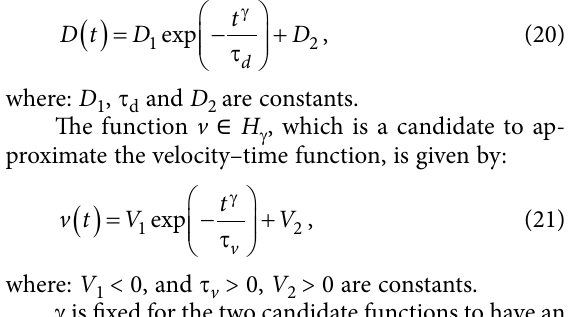
Fig. 8. Impact of the time headway on the velocity–density curve